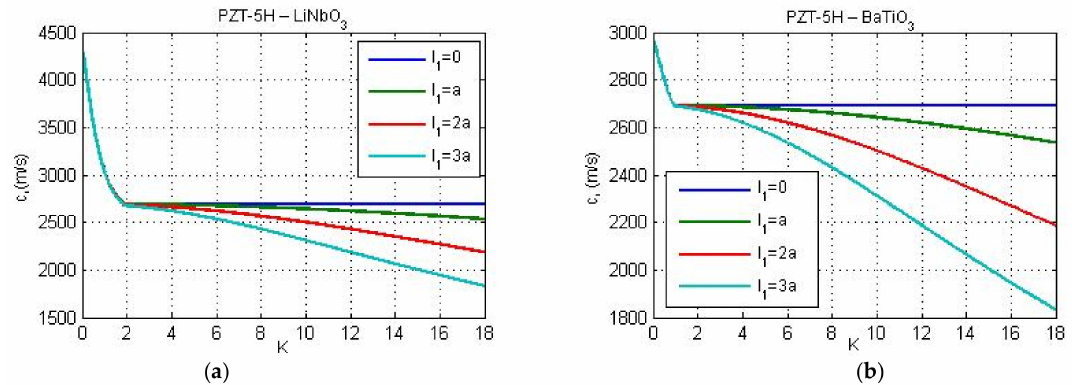
Figure 2. Phase velocity of Love wave versus non-dimensional wave number K = kh for two substrate materials: ( a ) LiNbO 3 , and ( b ) BaTiO 3 and for different micro-inertia characteristic lengths in case of electric open circuit conditions.